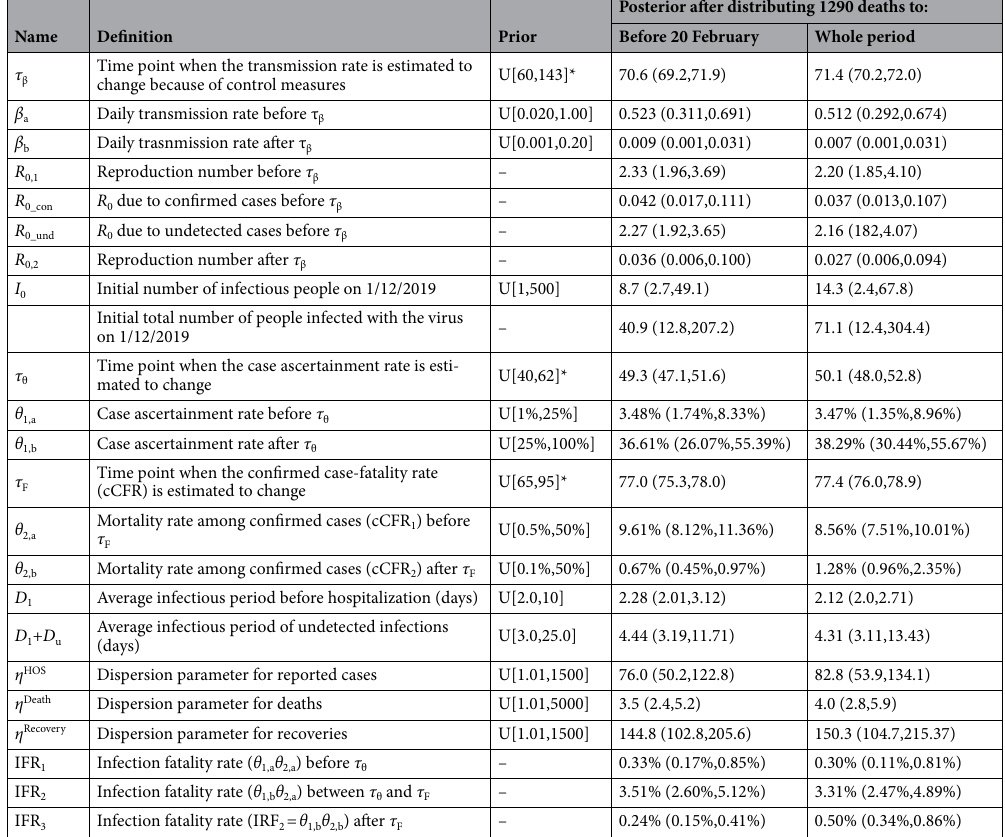
Table 2. Estimates of model parameters for the COVID-19 outbreak within mainland China. The 1290 deaths within Hubei province added on 17th April 2020 were distributed over either the period before 17th April (i.e., the whole period) or before 20th February 2020 in proportional to the daily number of deaths reported before 17th April 2020. The relative infectiousness of undetected cases compared to confirmed cases ξ = 1 (i.e., both undetected and confirmed infections are of the same infectiousness). The estimated values of model parameters are nearly the same for both ways of distributing 1290 deaths added on 17th April 2020 by Chinese National Health Commission except for estimates of cCFR 2 and IFR 3 . *The epidemic was assumed to start from 1st Dec 2019 1